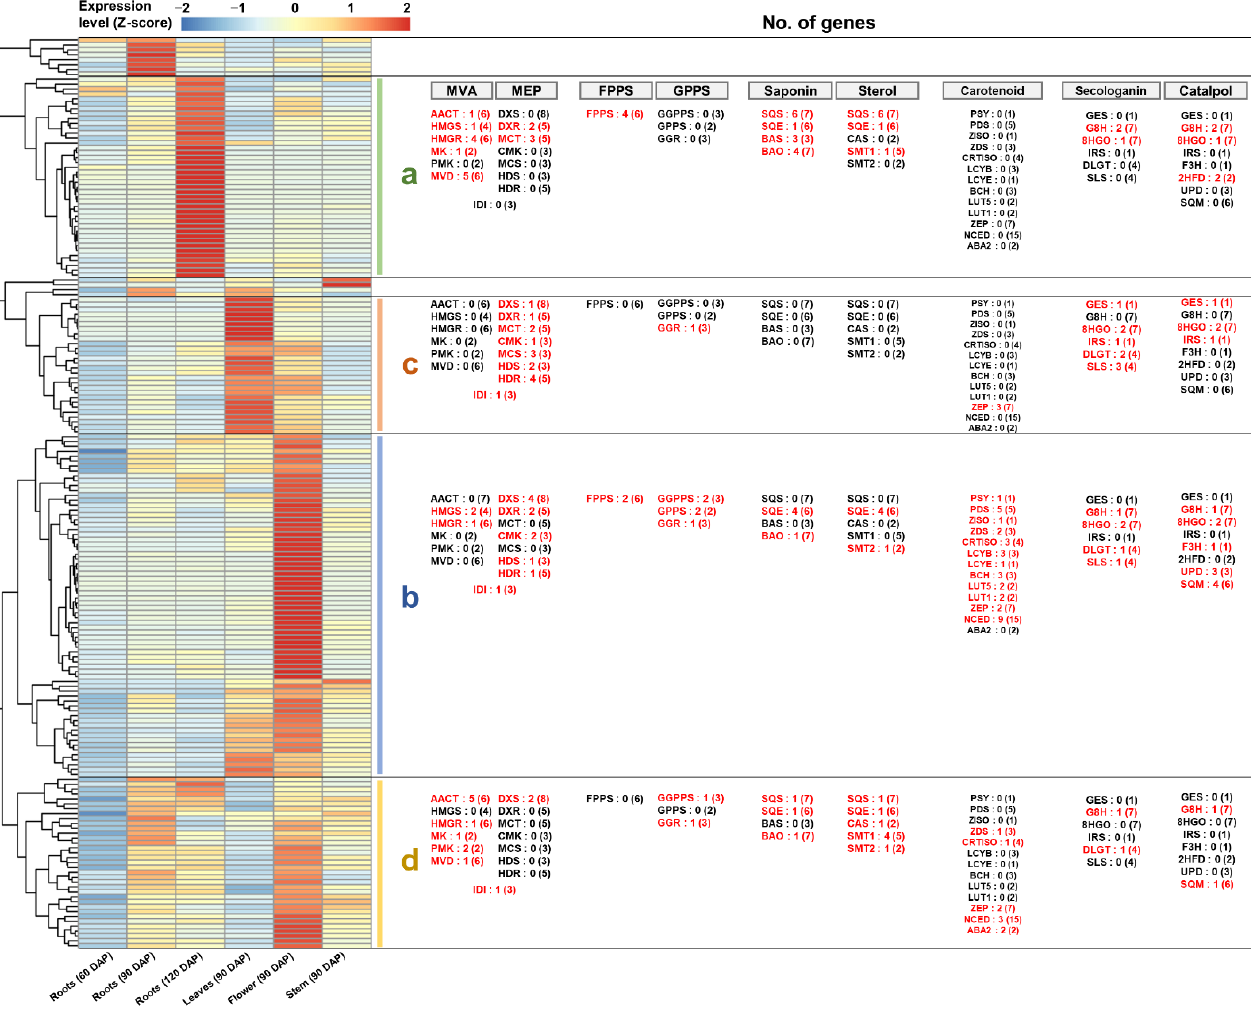
Figure 8. Comprehensive co ‐ expression analysis of genes responsible for terpenoid metabolism in R. glutinosa . ( a ) Genes cluster showing a high expression in the 120 DAP roots. ( b ) Genes cluster showing a strong expression in the 90 DAP flowers. ( c ) Genes cluster showing a high expression in the 90 DAP leaves. ( d ) Genes cluster showing a constitutive expression in most tissues. Genes highlighted in red indicate genes assigned to each cluster and the number in parentheses is the total number of genes encoding the enzyme expressed in R. glutinosa transcriptome.